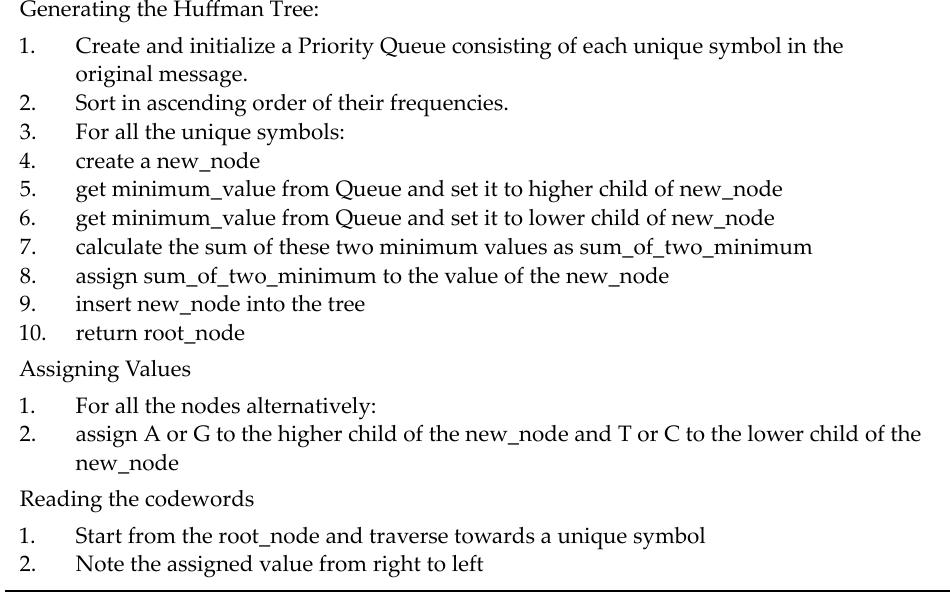
Algorithm 1: Proposed DNA‑based Huffman Coding